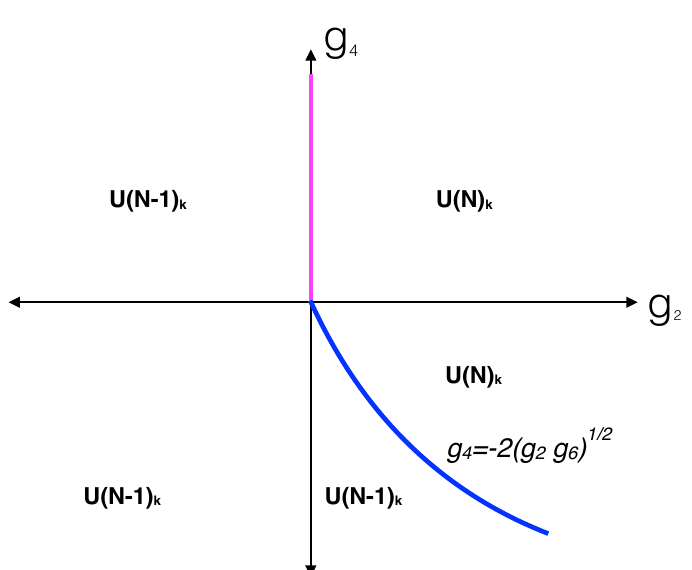
Figure 11. The phase structure of YM-CS theories as a function of the parameters of the scalar po- tential (4.16). This structure is reliable far away from the two axes, when both the regions marked by U( N